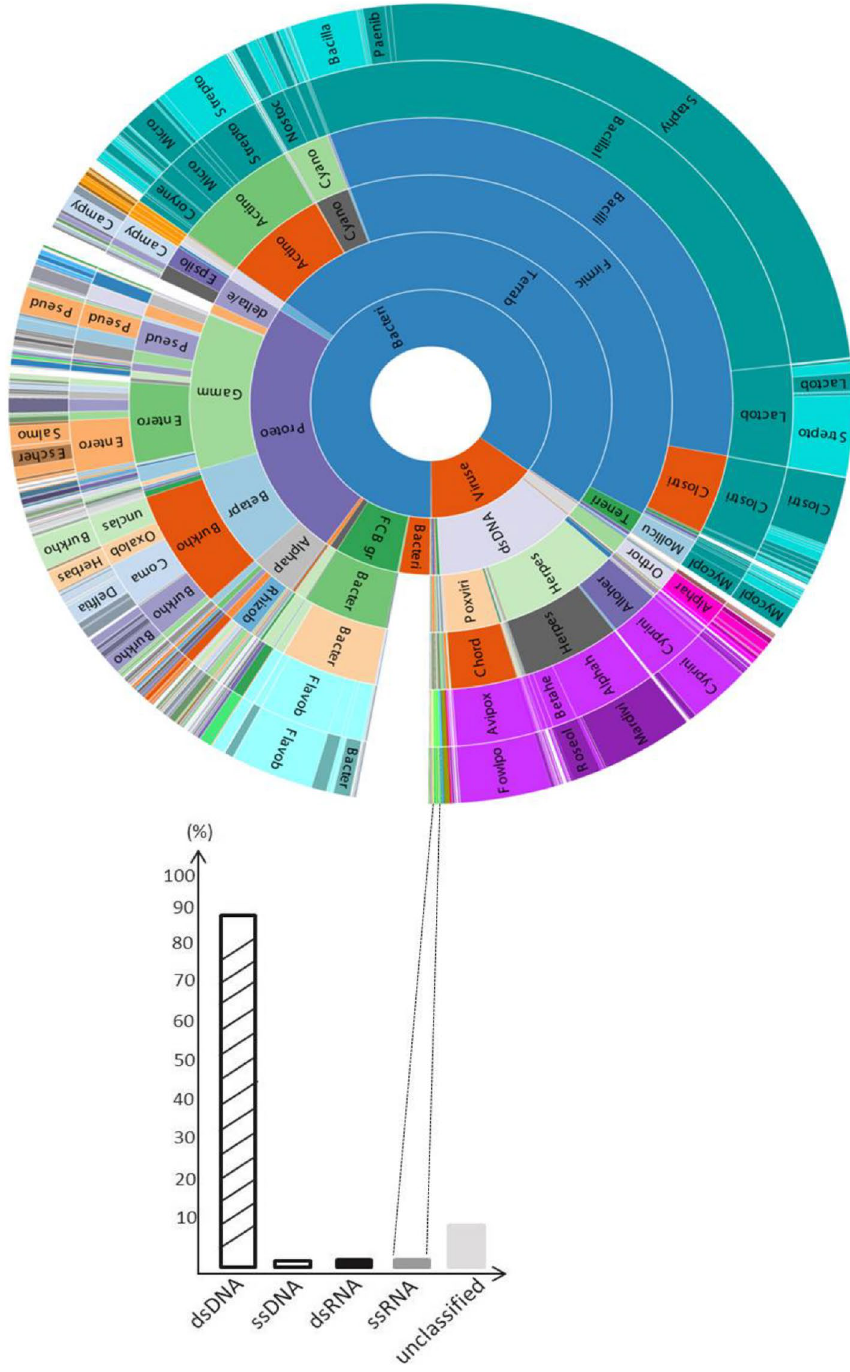
Figure 3. Metagenomics profiling of the 19-03914 liver sample from a pheasant flock in France. The metagenomics profiling represents all families in different color and/or different color gradients. All identified de novo assembled virus contigs from metagenomics profiling are shown in the bar graph, where the percentage of the coverage of double-stranded (ds), single-stranded (ss) viral DNA and RNA, as well as unclassified viruses is